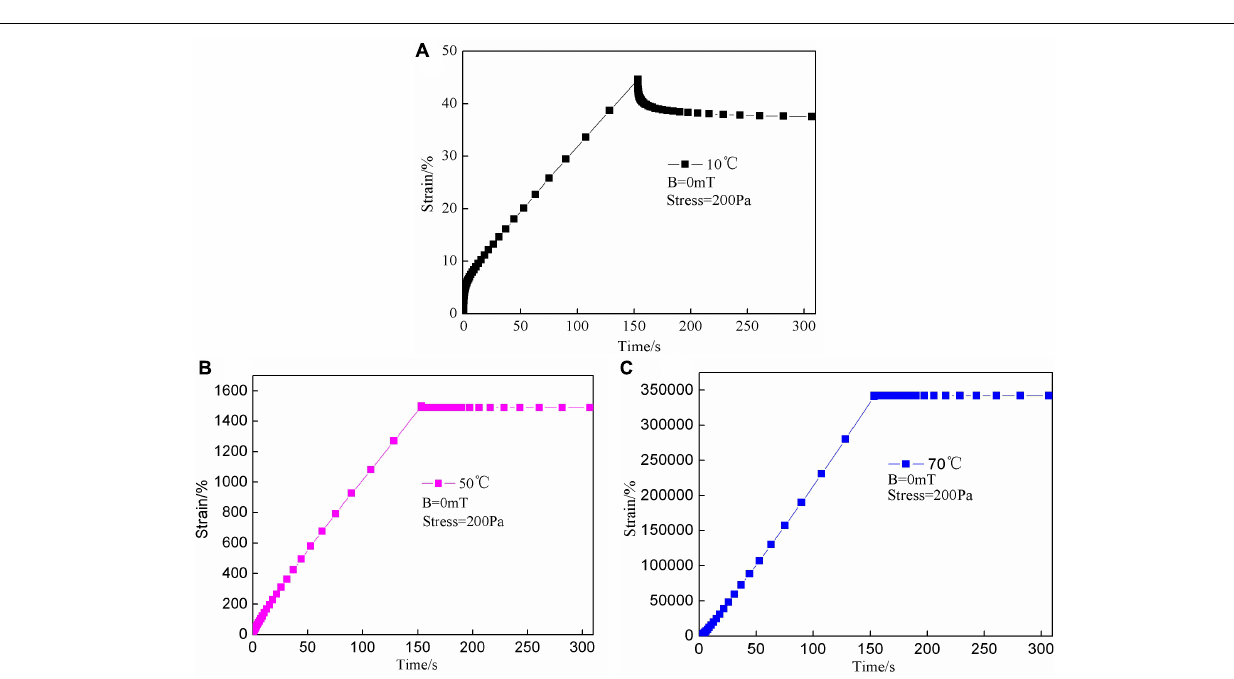
FIGURE 10 | The creep and recovery curves of MRG-70 under a 200 Pa constant stress for MRG-70 under different temperatures (A) T = 10 ◦ C; (B) T = 50 ◦ C; (C) T = 70 ◦